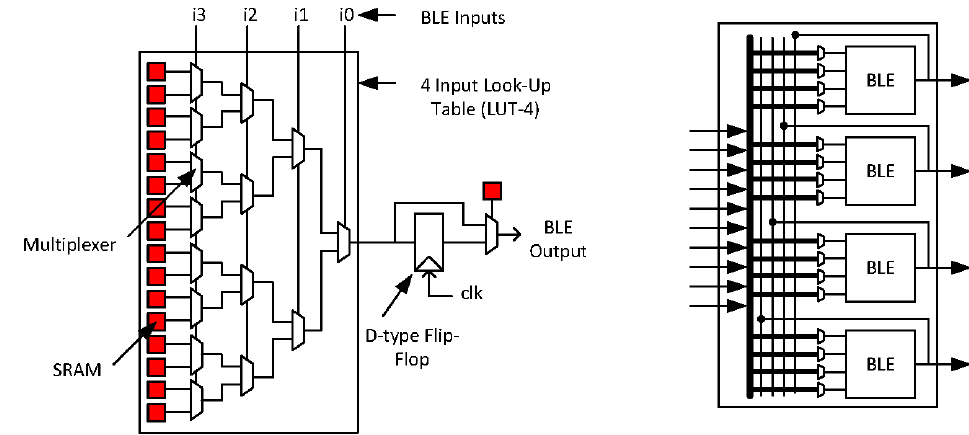
Figure 4. A typical example of mapping and packing process used in FPGA backend